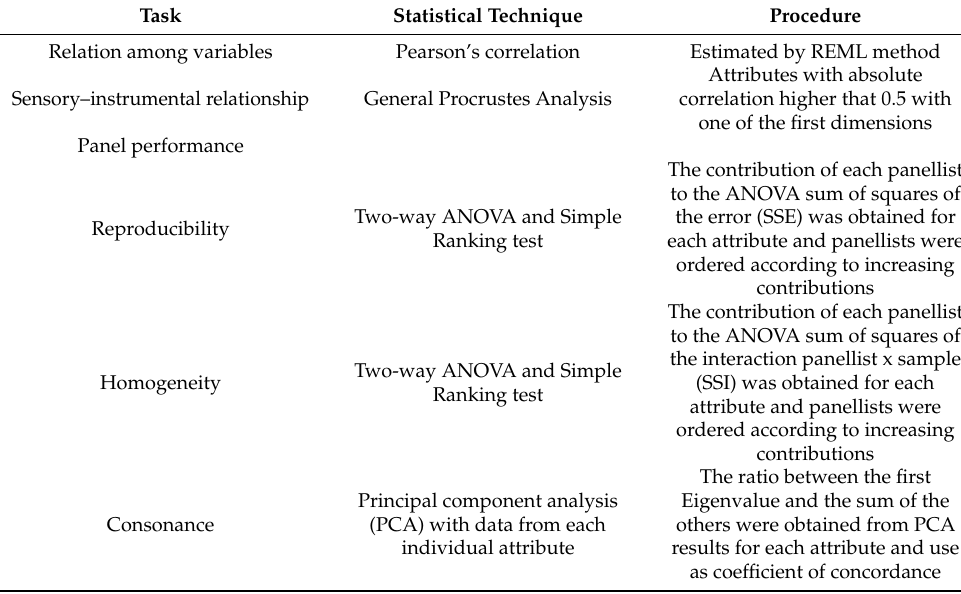
Table 2. Performed task, techniques, and